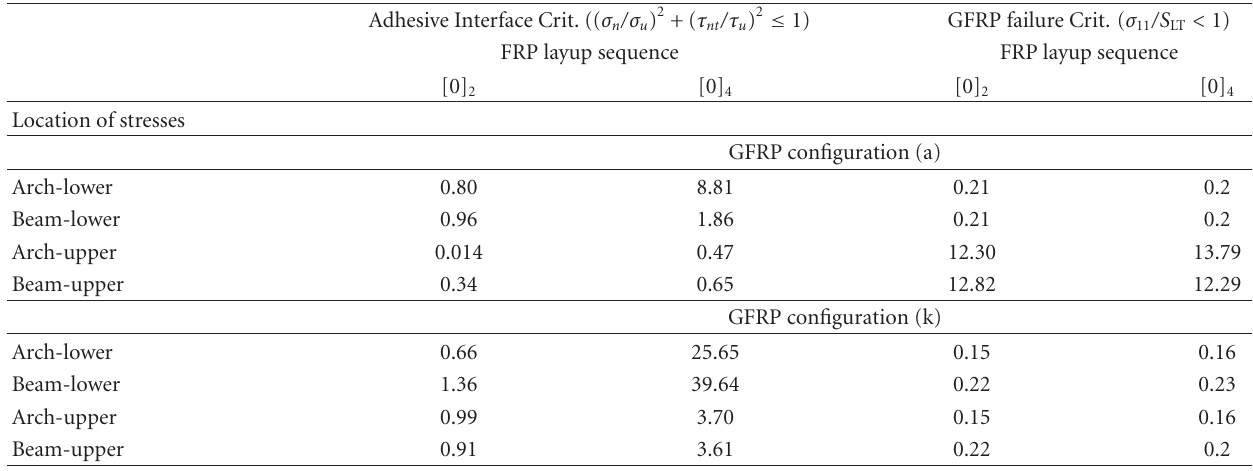
Table 3: Comparison of the maximum values obtained by the use of failure criteria for the adhesive interface and GFRP obtained by FE analysis.